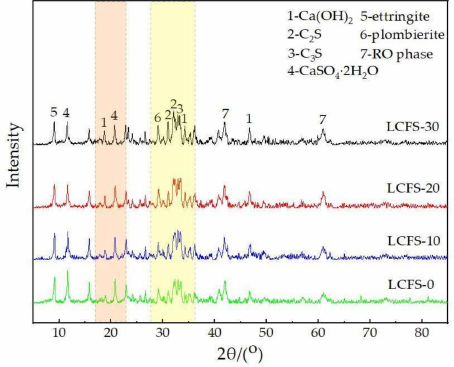
Figure 10. XRD patterns of LCFS-GBFS composite cementitious materials pastes at 28 days.